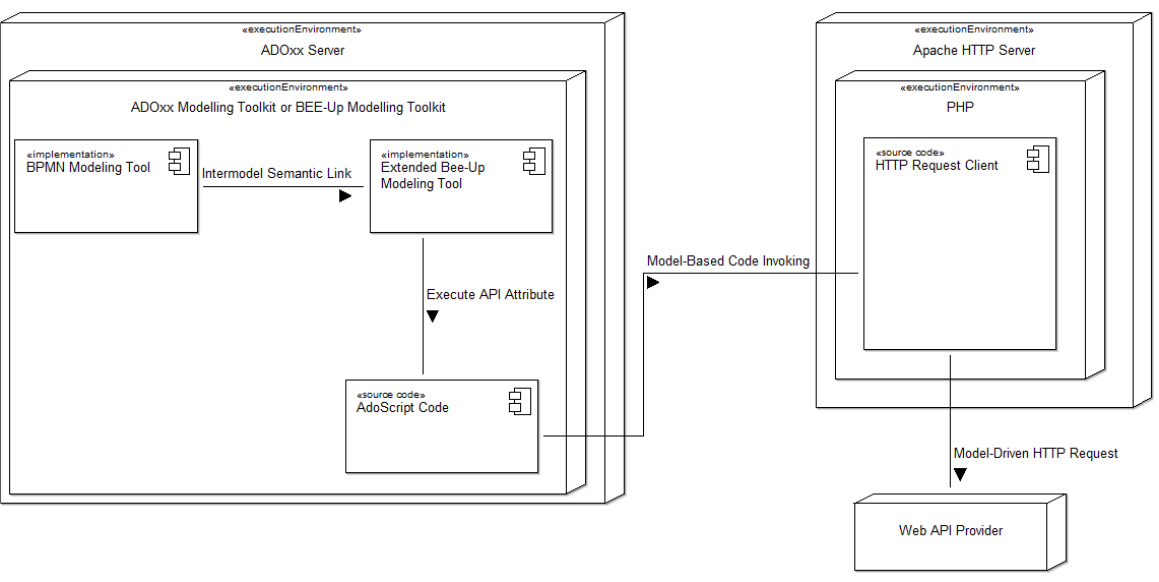
Figure 11. Deployment